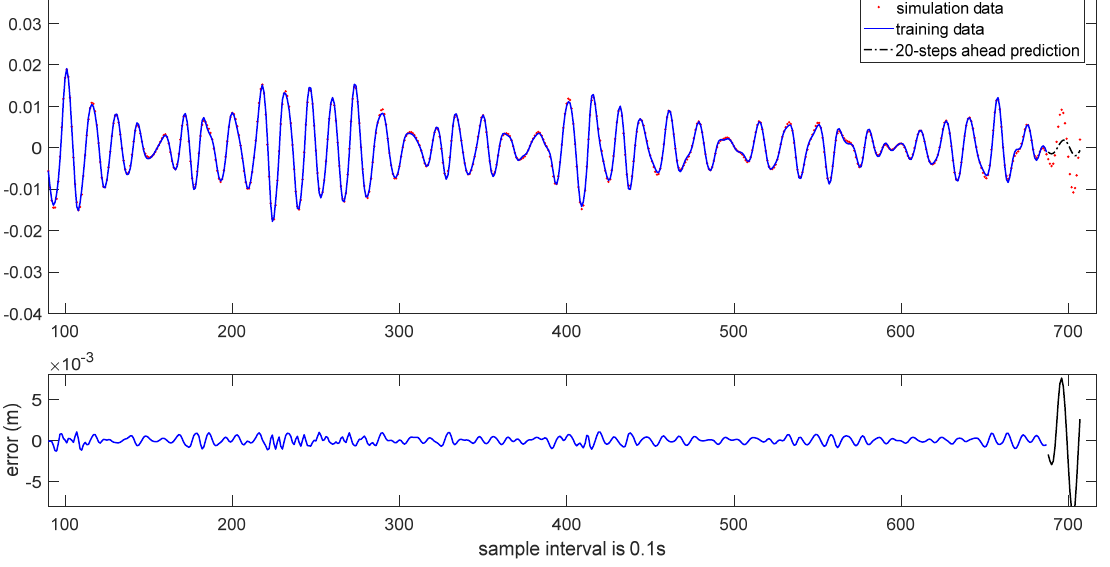
Figure 10. The 20-steps-ahead prediction of heave motion in irregular waves at the instant k = 687 for the R-Class Icebreaker model.